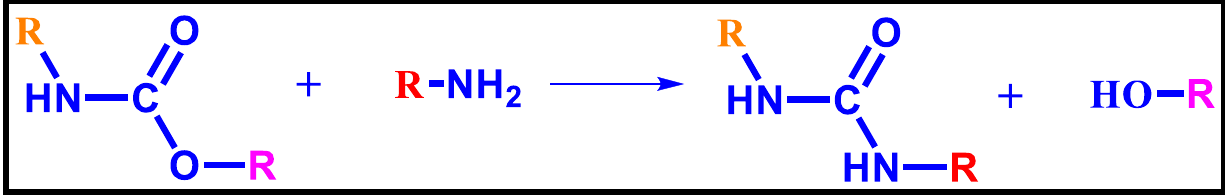
Figure 13. Aminolysis of Polyurethanes [115].